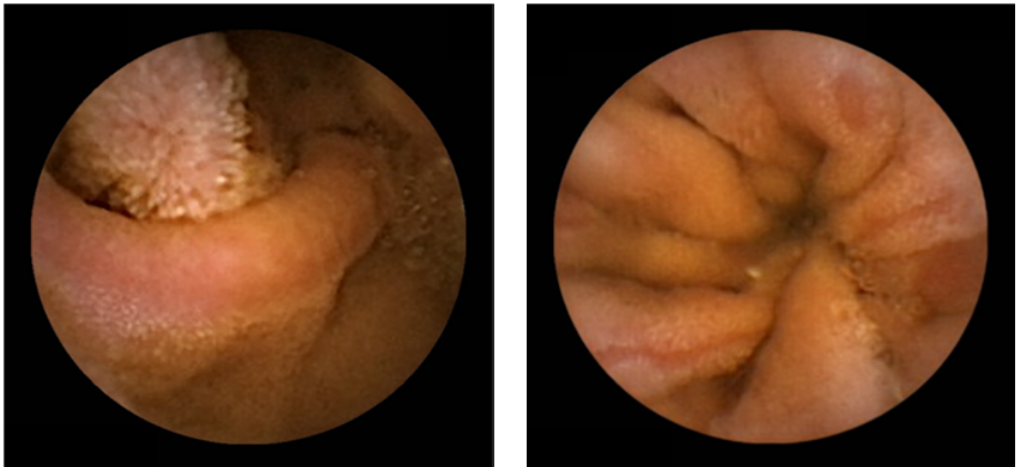
Figure 5. Example of typical denuded areas found in the